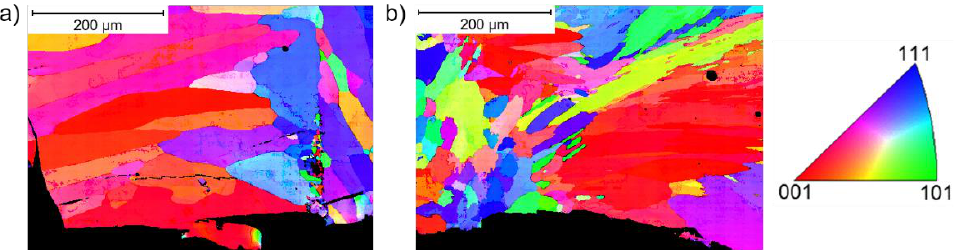
Figure 11. ( a ) UTS and ( b ) rupture elongation (A t ) of the 17Cr2 and HiperFer AM variants (LPD and